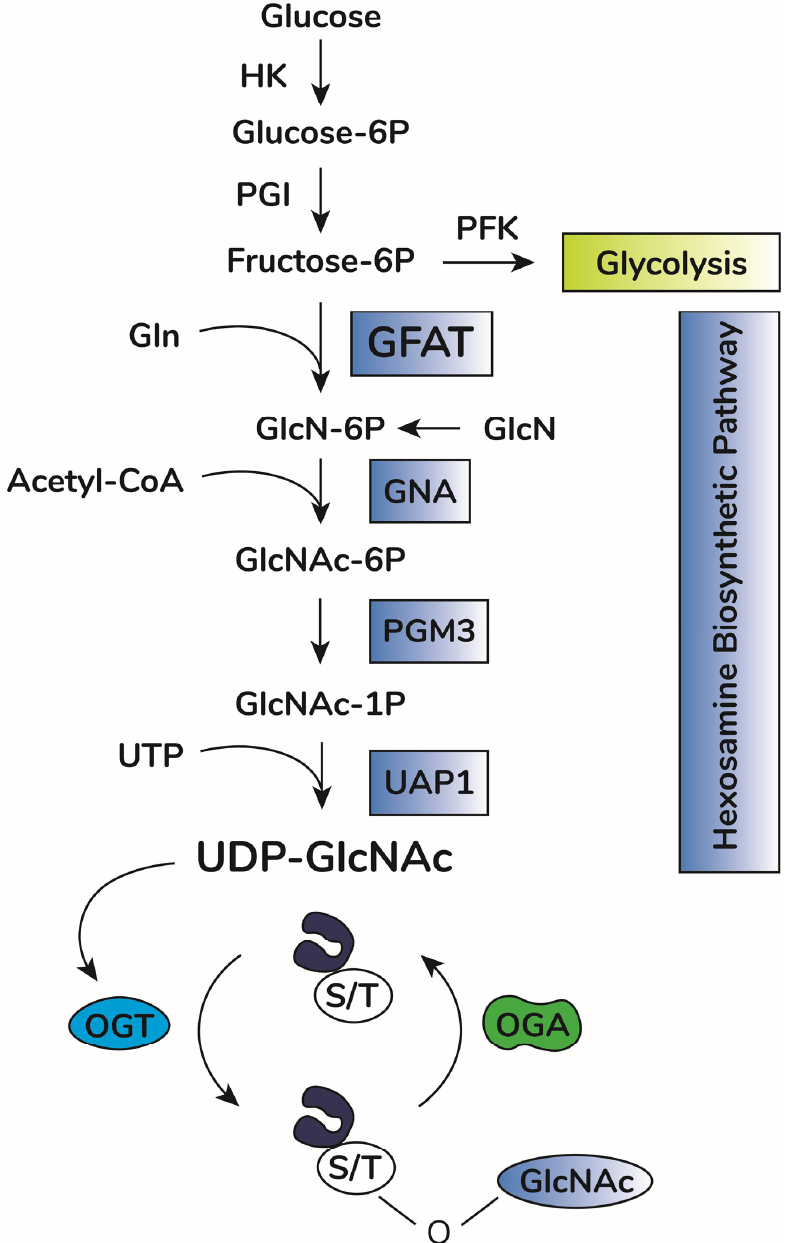
Figure 1. O-GlcNAc cycling scheme. Upon entry in cells, glucose is rapidly phosphorylated to glucose-6-phosphate (Glucose-6P) by hexokinase (HK). Glucose-6P is isomerized by phosphoglucose isomerase (PGI), producing fructose-6-phosphate (Fructose-6P), a substrate for both phosphofruc- tokinase (PFK) of the glycolytic pathway or glucosamine-fructose amino transferase (GFAT), the rate-limiting reaction of the hexosamine biosynthetic pathway (HBP). GFAT requires glutamine (Gln) as the amine donor for generating glucosamine-6-phosphate (GlcN-6P), which is then N-acetylated by glucosamine-6-phosphate N-acetyltransferase (GNA1), producing N-acetyl-glucosamine- 6-phosphate (GlcNAc-6P). This step requires acetyl-CoA as the acetyl donor. GlcNAc-6P is trans- formed in GlcNAc-1P by phosphoacetylglucosamine mutase (PGM3). Using UTP as the nucleotide donor, UDP-N-acetylglucosamine pyrophosphorylase (UAP1) produces uridine-diphosphate N-ac- etyl glucosamine (UDP-GlcNAc). This molecule is the substrate of O-GlcNAc transferase (OGT) for protein O-GlcNAcylation by adding O-linked GlcNAc moieties at serine or threonine residues of target proteins. O-GlcNAcase (OGA) removes GlcNAc residues, counteracting OGT activity.